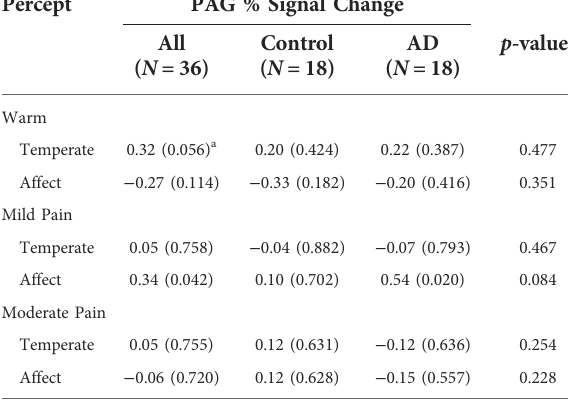
TABLE 4 Correlations of the PAG percent signal change with the stimulus temperature needed to elicit each pain percept and affective ratings at each percept for the entire sample and within each